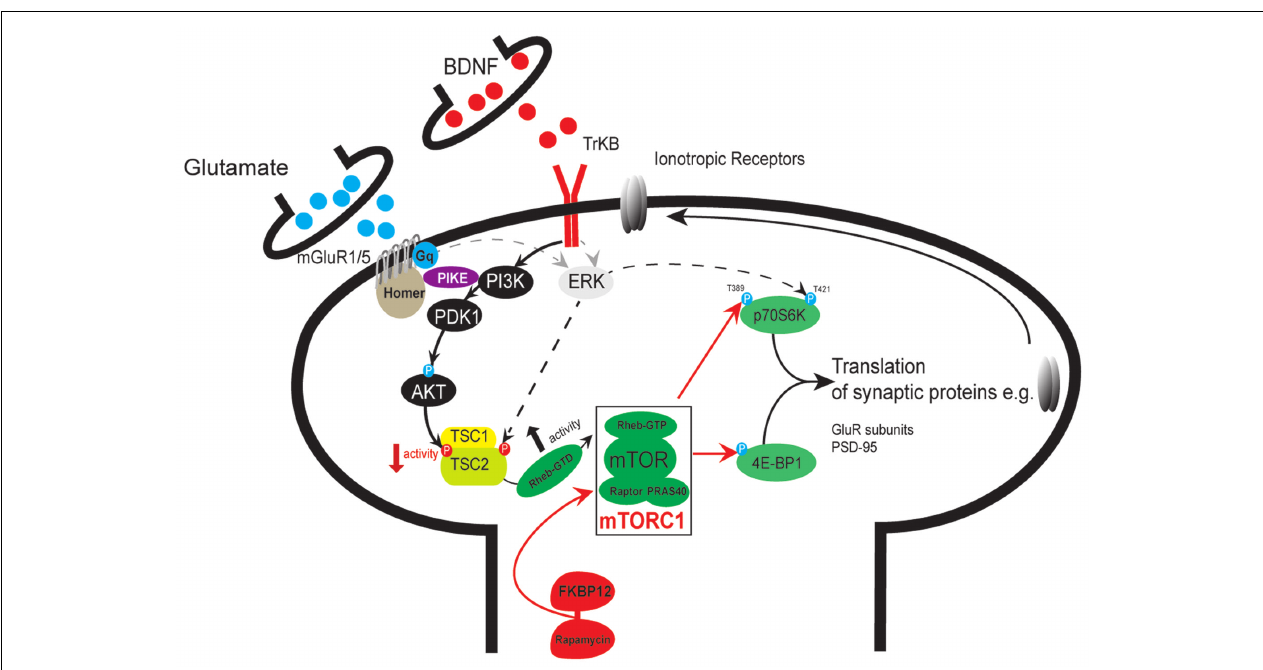
(FKBP12-rapamycin). mTORC1 phosphorylates 4E-BPs, a family of translational repressor proteins, which leads to their dissociation from eIF4E, enabling it to form the eIF4F complex for cap binding and participation in the initiation of translation of a range of mRNAs.Thus, mTOR-mediated phosphorylation of 4E-BPs and S6Ks leads to increased translation of mRNA – including transcripts that encode proteins required for synaptic plasticity such as GluR1 AMPARs. Akt, also known as protein kinase B; BDNF, brain-derived neurotrophic factor; ERK, extracellular signal-regulated protein kinase; 4E-BPI, eukaryotic initiation factor 4E-binding protein; FKBP12, FK506-binding protein 12; Gq, Gq-protein; mGluR, metabotropic glutamate receptor; mTOR, mammalian target of rapamycin; NMDAR, N -methyl-D-aspartate receptor; PI3K, phosphoinositide-3 kinase; PIKE, PI3K-enhancer; mTORC1, mTOR complex 1; PDK1, phosphoinositide-dependent kinase 1; PRAS40, proline-rich Akt/PKB substrate 40 kDa; Raptor, regulatory-associated protein withTOR; Rheb, Ras homolog enriched in brain; S6K, p70 S6 kinase;TrkB, tyrosine receptor kinase B;TSC1/2, tuberous sclerosis complex 1 and 2;T, threonine; P,